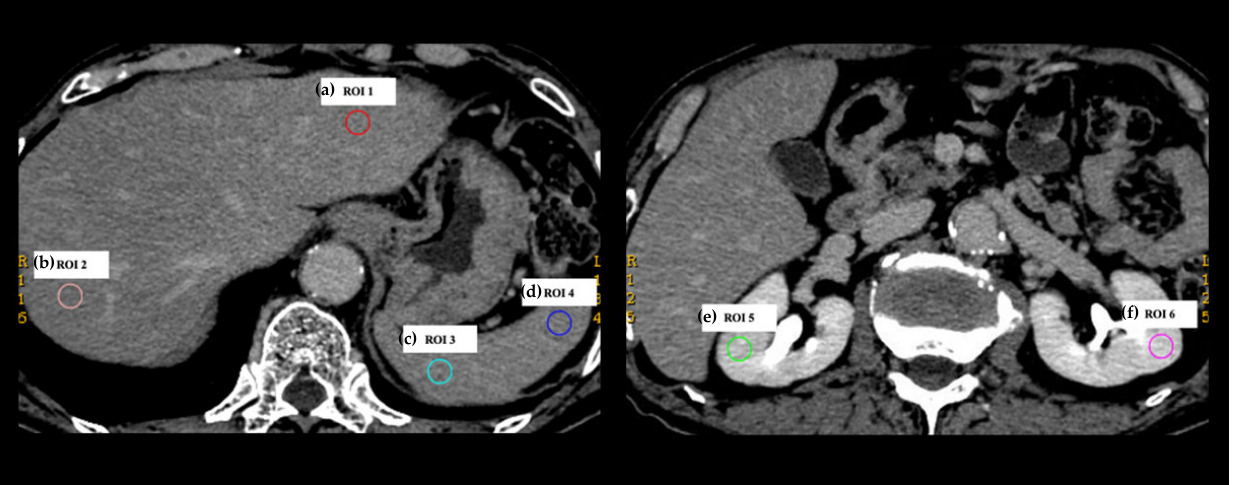
Figure 2. Placement of regions of interest (ROIs) on 70 ‐ keV virtual monochromatic image. Six ROIs were marked on each non ‐ contrast ‐ enhanced and contrast ‐ enhanced triple ‐ phasic CT image from 30 patients, respectively, avoiding vessels, bile ducts, and the renal calyx. The locations of the six ROIs were as follows: ROI 1, the left hepatic lobe; ROI 2, right hepatic lobe; ROI 3, the dorsal side of the spleen; ROI 4, the ventral side of the spleen; ROI 5, right renal parenchyma; and ROI 6, left renal parenchyma. Six DECT numbers, including CT attenuation in (a) 70 and (b) 40 keV virtual monochromatic images (70 and 40 keV CT values), (c) the slope of the spectral CT attenuation curve (slope), (d) effective atomic number (effective Z), (e) iodine concentration (IC), and (f) water concentration (WC), were automatically calculated for each ROI. As a result, 4,320 DECT numbers (30 patients × 4 phasic CT images × 6 DECT parameters × 6 locations) were collected.